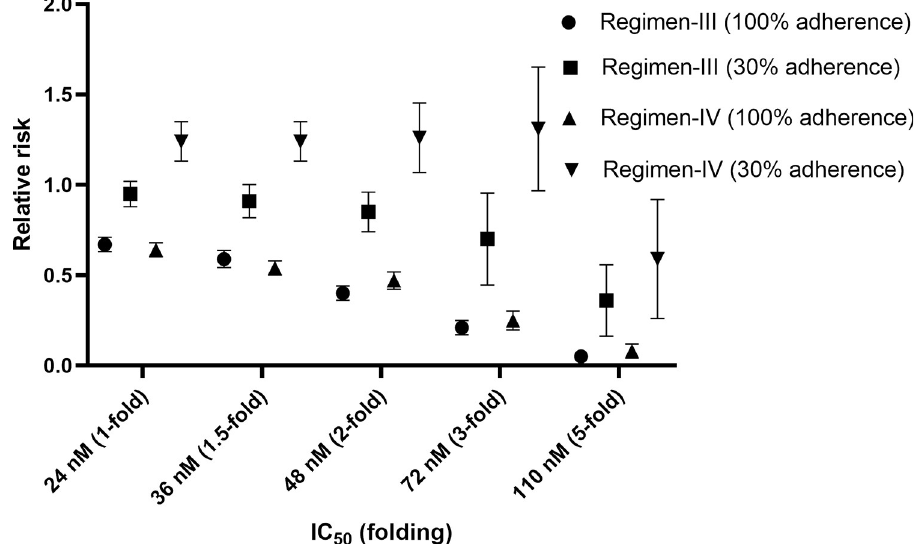
Fig 6. Comparisons ofrelative risk of two propose regimens (III, and IV) between 100% of adherence and 30% of adherence in patients with resistant mefloquine.